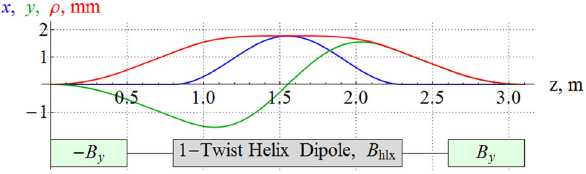
Fig. 4 Deflectionoftheclosedorbitintheregionwithahelicalmagnet at p = 20 GeV/c.Theblue x andgreen y linesaretheradialandvertical components of the closed orbit, respectively, and the red ρ line is the absolute distance to the design orbit